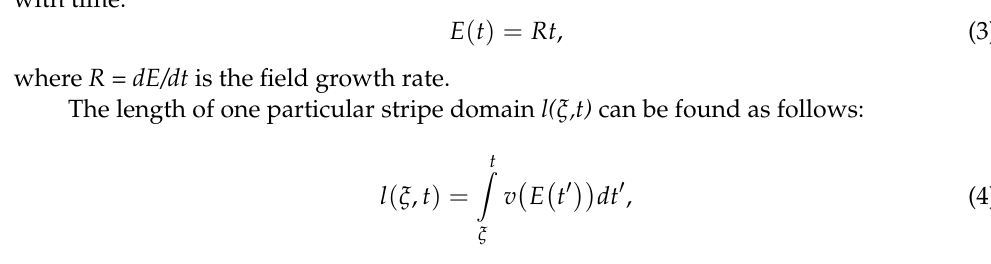
Figure 7. Growth of hexagonal domains in the fields above 21.5 kV/mm. Instantaneous optical im- ages of the domain structure during polarization reversal under the field of 22 kV/mm. The time intervals from the start of field pulse application: ( a ) 220 ms, ( b ) 228 ms, ( c ) 236 ms, ( d ) 244 ms. Optical microscopy, transmitted light.